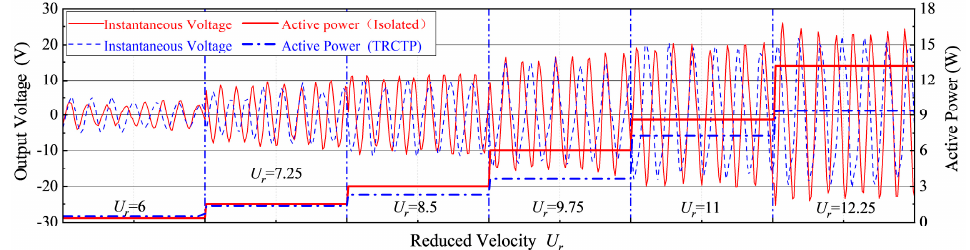
Figure 20. Active power and the instantaneous voltage for L / D = 4.